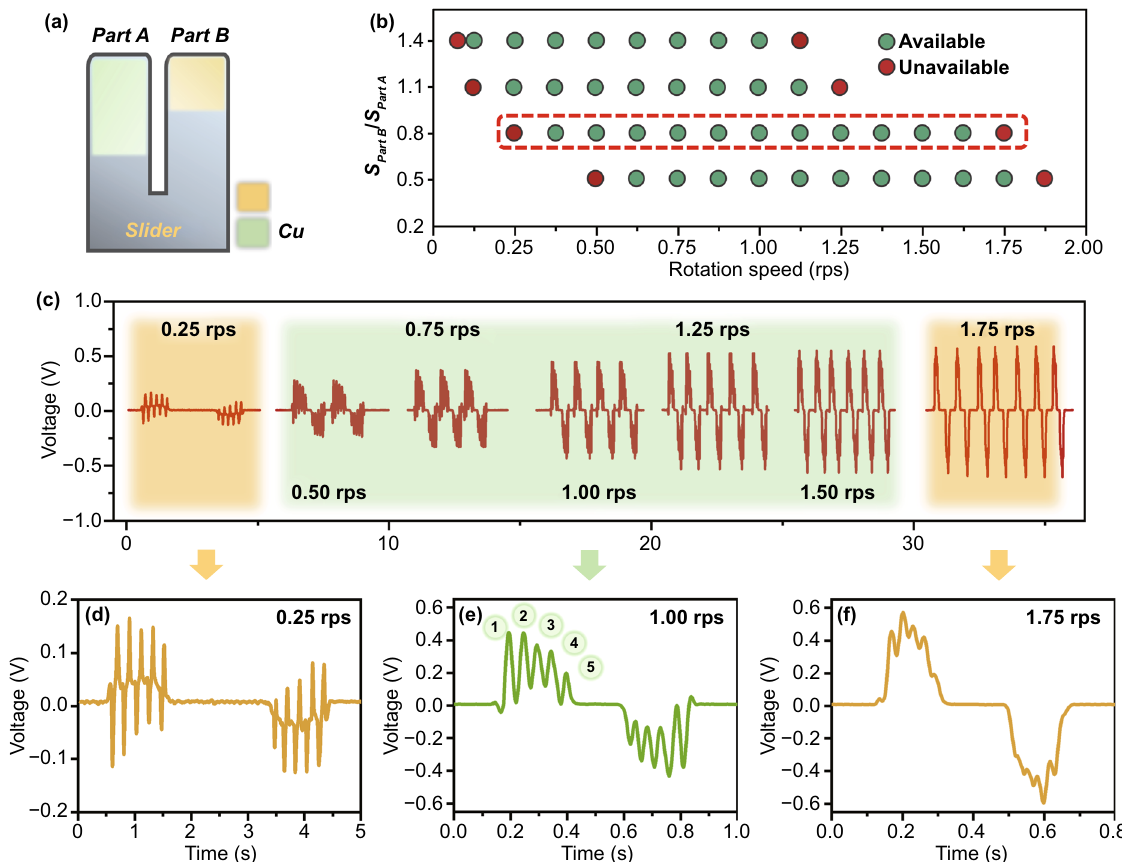
Fig. 4 Matching of two coupled parts of the slider. a Area adjustment diagram of the two parts. b Speed response range under different area ratio of part B to part A. c Test signals at rotation speed from 0.25 to 1.75 rps under area ratio of 0.8. d–f Enlarged signal of Fig. 4c at rotation speed of 0.25, 1.00, and 1.75